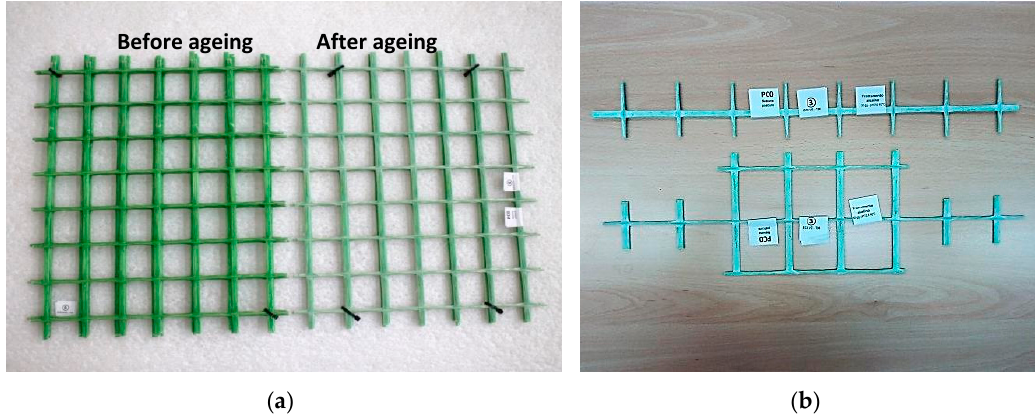
Figure 4. GFRP grids after exposure in alkaline bath. ( a ) Comparison between aged and unaged grid; ( b ) Aged specimens.